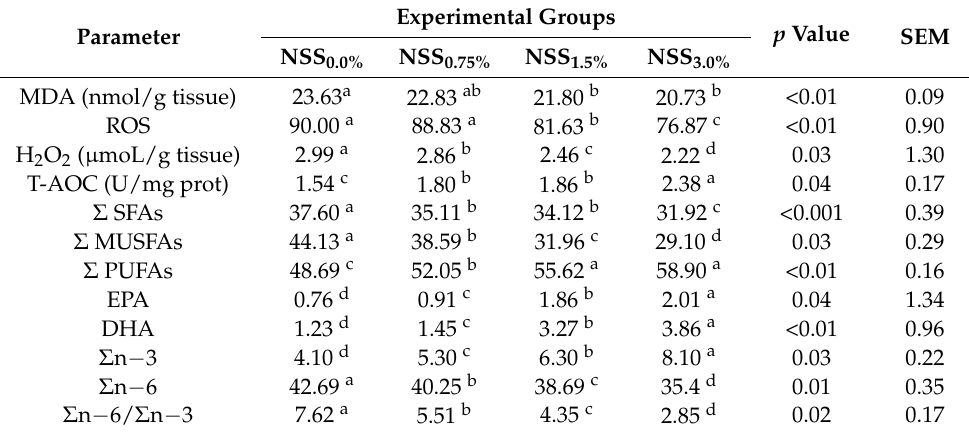
Table 6. Oxidative/antioxidant status and fatty acid profile in muscle tissues of Nile tilapia ( O. niloticus ) fed diets supplemented with varying levels of a microalgae mix (NSS) containing Nannochloropsis oculate and Schizochytrium and Spirulina species at equal proportions (1:1:1) for 12 weeks.